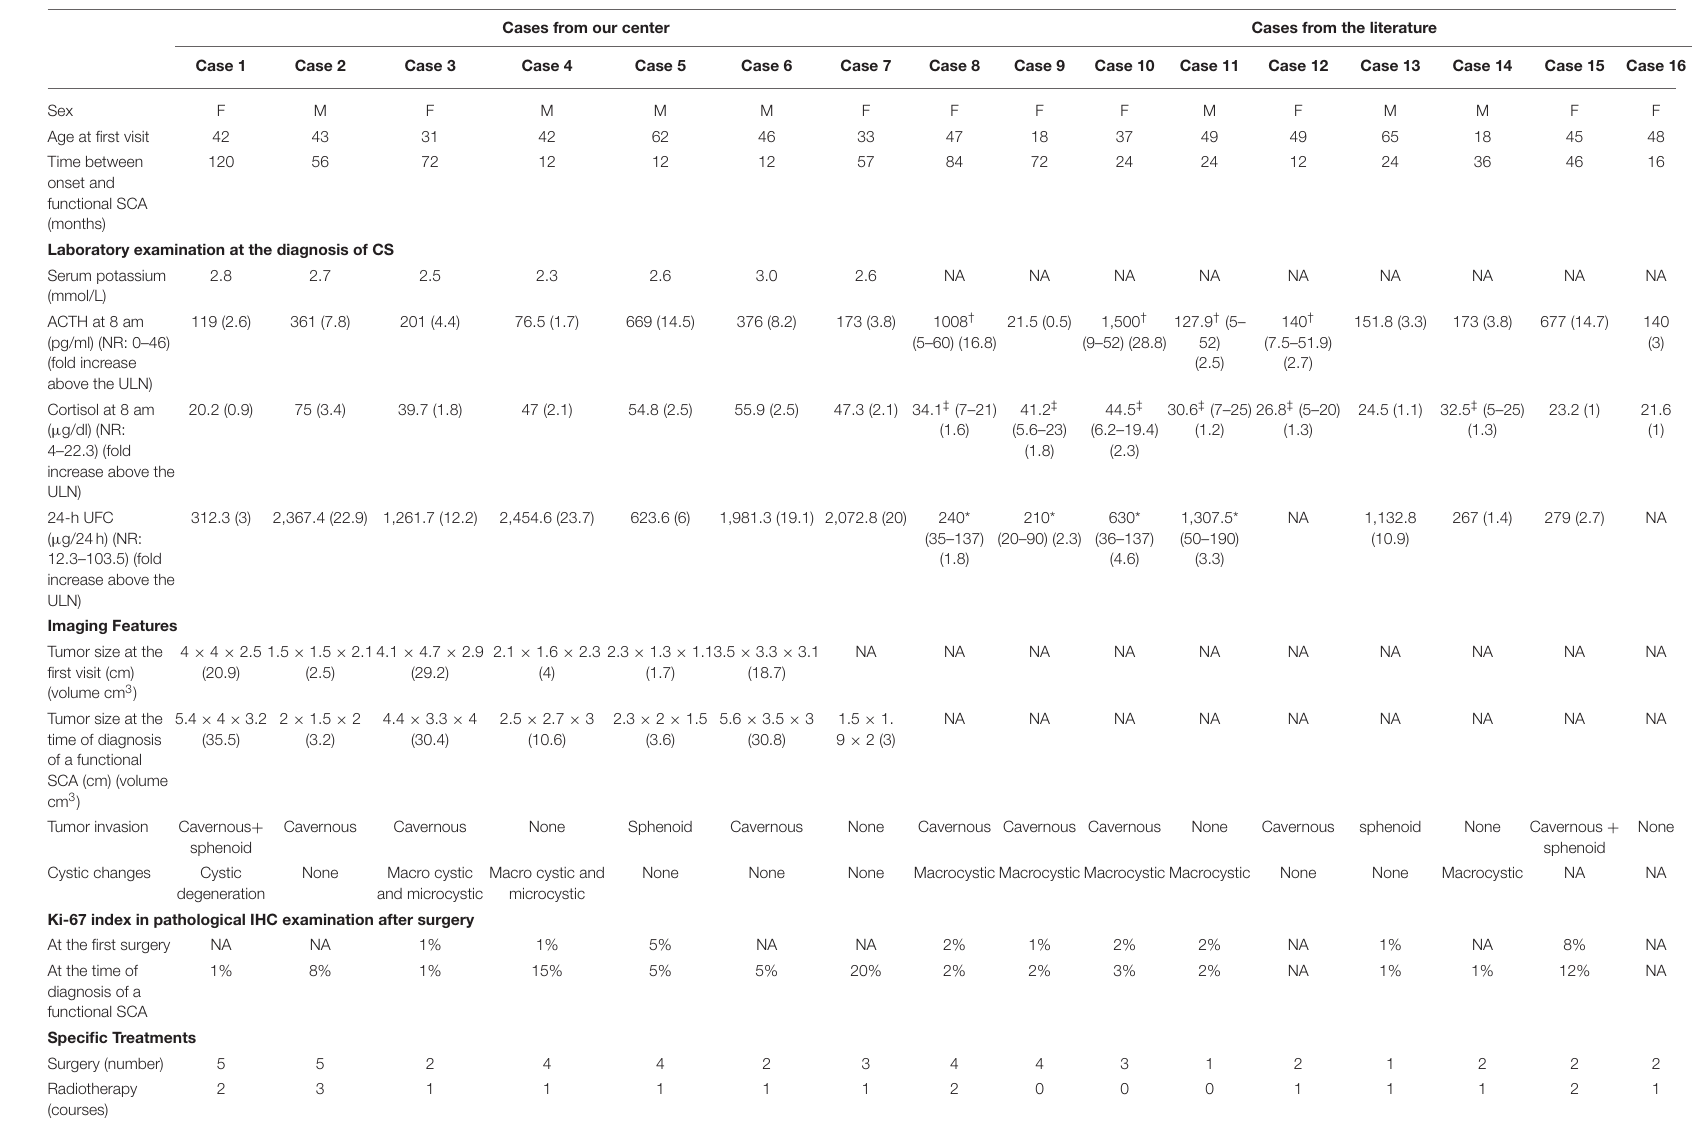
TABLE 1 | Clinical features, imaging features, IHC features, and treatment of 16 patients with a transformation to functional